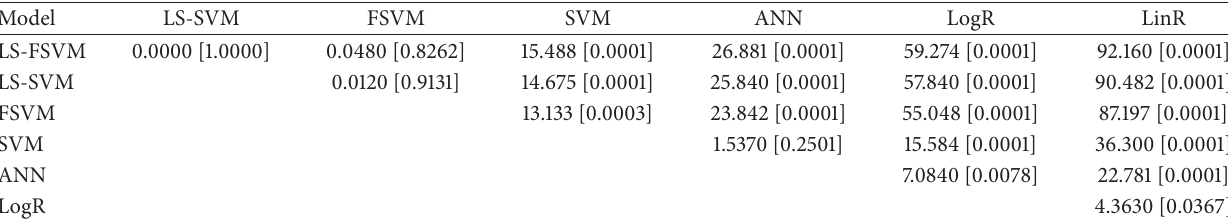
Table 4: McNemar’s test for pairwise performance comparison of different